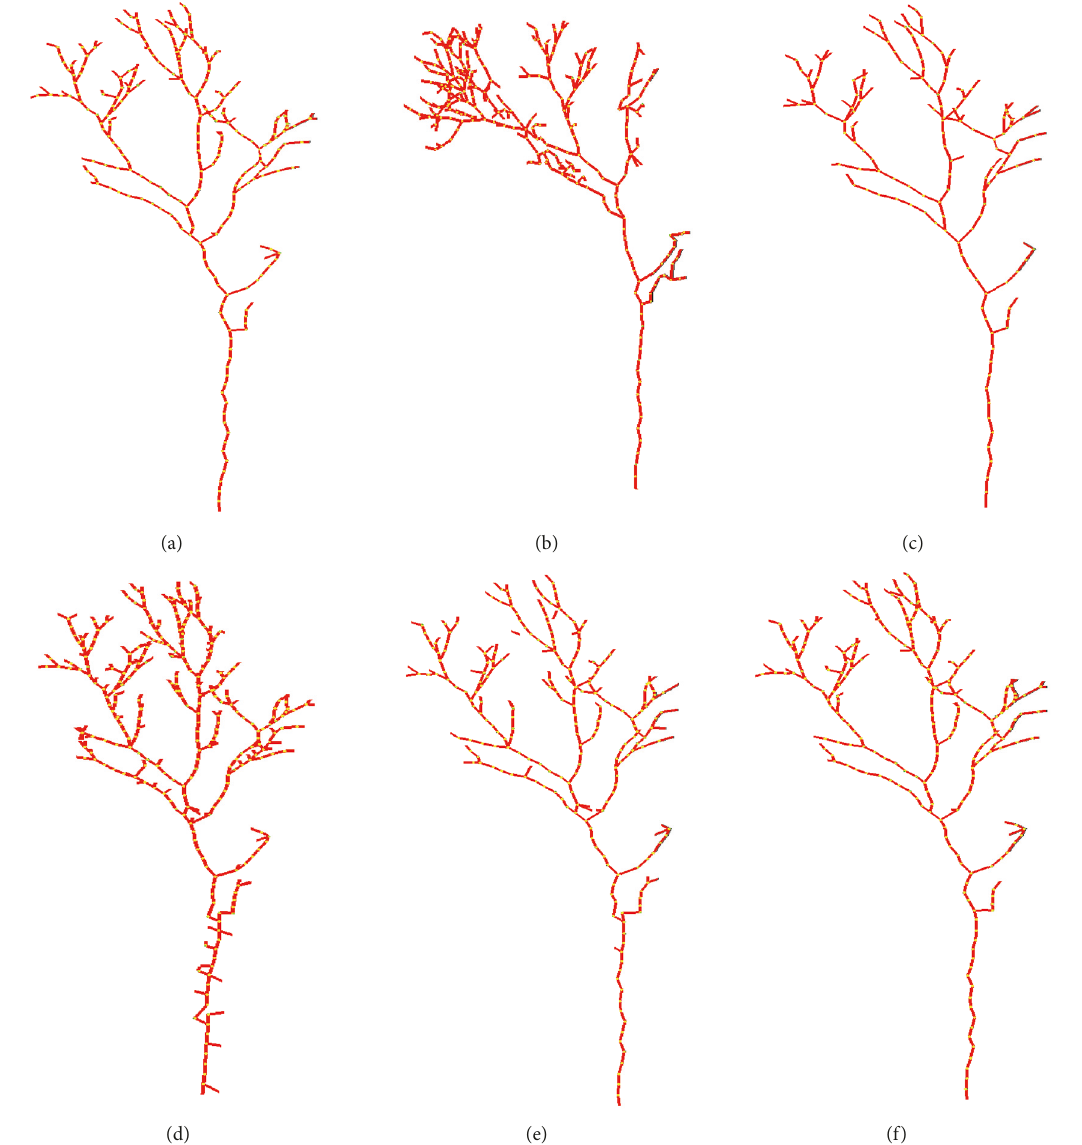
Figure 10: Skeleton extraction result. (a) The skeleton (0.015 60 80 True). (b) The skeleton (0.025 60 80 True). (c) The skeleton (0.015 40 80 True). (d) The skeleton (0.015 60 0 False). (e) The skeleton (0.015 60 80 False). (f) The skeleton (0.015 60 0